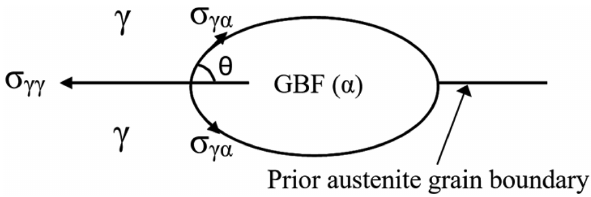
Figure 12: Schematic illustration of ferrite nucleation from prior austenite grain boundary (PAGB)